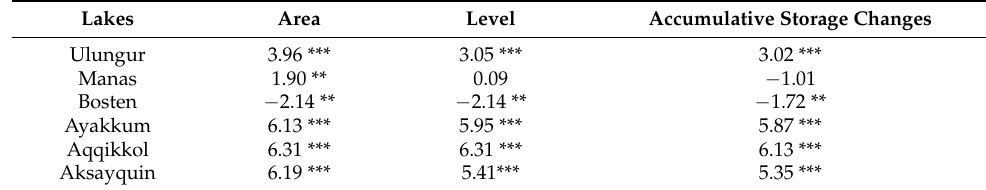
Table 4. Z statistic of Mann–Kendall test of lake dynamics for six lakes from 2000 to 2020. Lakes Area Level Accumulative Storage Changes Ulungur